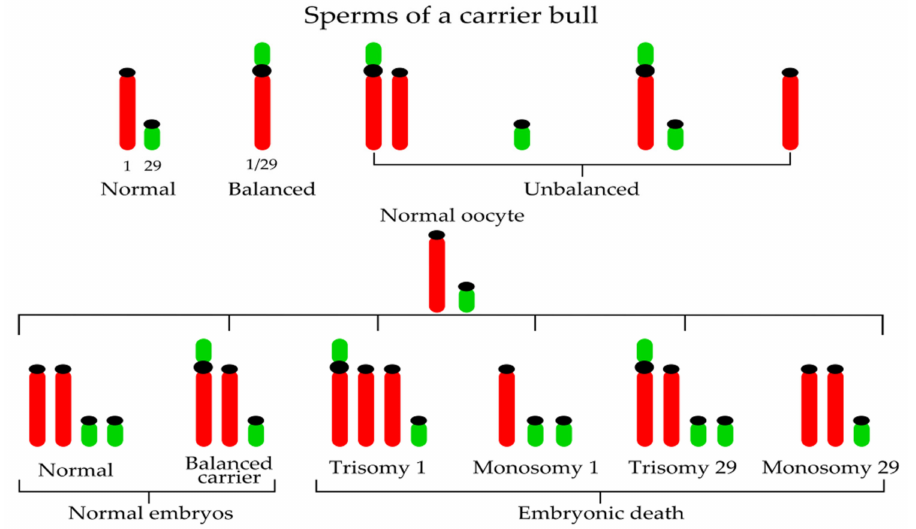
Figure 2. Examples of chromosomal combinations in embryos resulting from the mating of a heterozygous carrier bull 1;29 and a normal